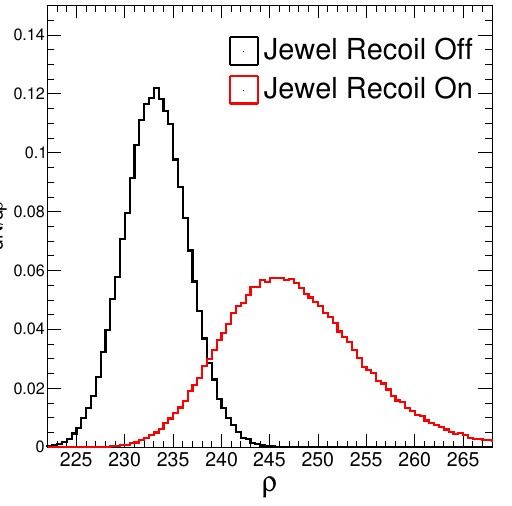
Figure 1 . The median grid energy density ρ ( GeV per unit area) used in the background subtraction procedure, for Jewel dijet events with recoils on/off mixed with most-central thermal